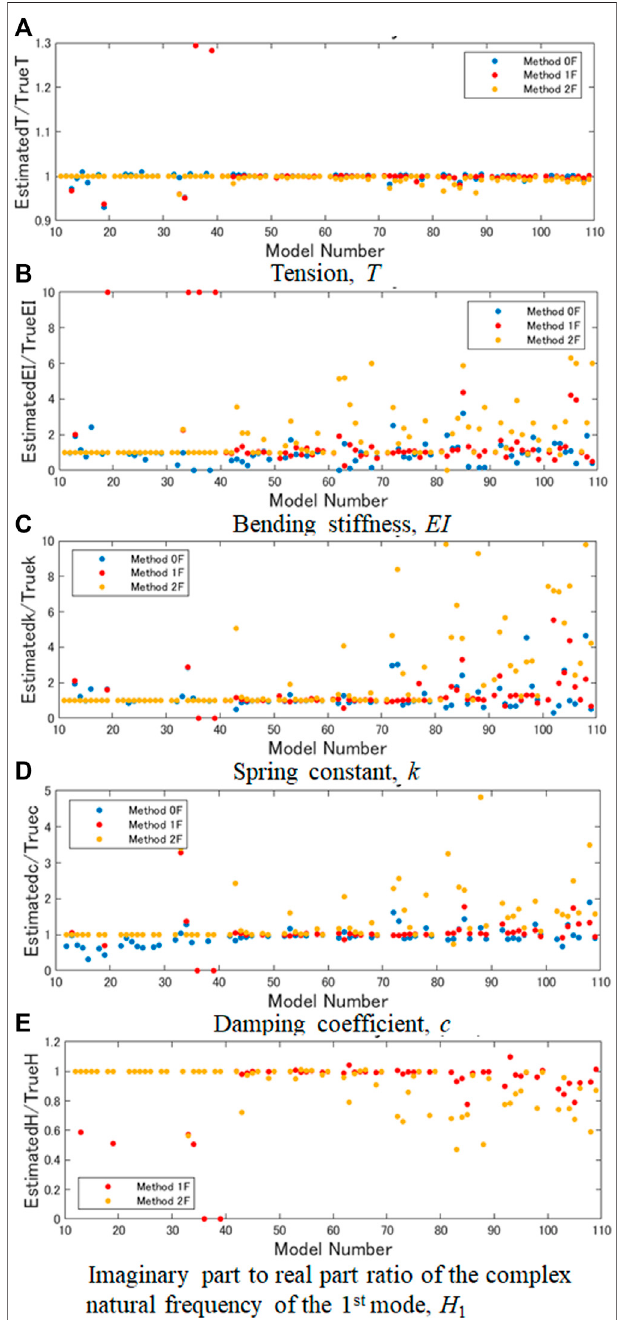
FIGURE 4 | Estimation results for a cable with a viscous shear damper: (A) tension, T ; (B) bending stiffness, EI ; (C) spring constant, k ; (D) damping coef fi cient, c ; (E) imaginary part to real part ratio of complex natural frequency of 1 st mode, H 1 .